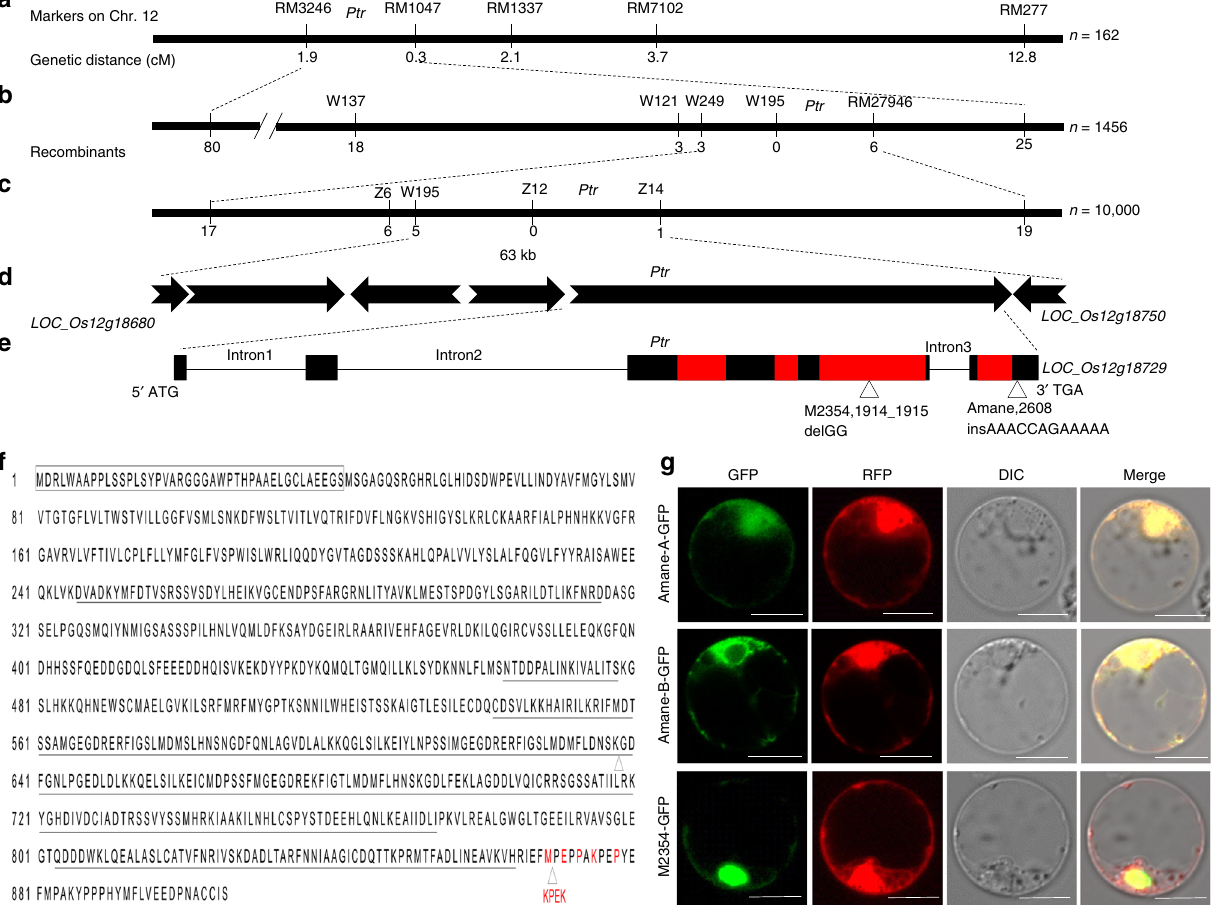
Fig. 1 Cloning and characterization of Ptr . a Ptr was mapped between SSR RM3246 and RM1047 on chromosome 12 (Chr. 12). b , c Fine mapping of Ptr to 63 kb. d Predicted open reading frames (ORFs) with indicated direction of transcription. e Diagram of Ptr , mutations identi fi ed in M2354 and Amane. Exons are indicated by black fi lled rectangles. Armadillo (ARM) repeats (Superfamily 1.75) are indicated by the red fi lled rectangles. Insertion/deletion (InDel) is indicated by triangles. f The protein sequence of Ptr in Katy. Black rectangle indicates 41 missing amino acids in A isoform (864 amino acids) compared to B isoform (905 amino acids). The ARM repeats are underlined and polymorphic regions are indicated by triangles. Compared to Katy, the 2 bp (GG) deletion of Ptr in M2354 resulted in a truncated protein with 645 amino acids, while fi ve different amino acids, as well as a four amino acid (KPEK) insertion in Amane, are indicated in red. g Subcellular localization of the Ptr-green fl uorescent protein (GFP) fusion proteins in rice protoplasts expressing cytoplasmic/nuclear-localized red fl uorescent protein (RFP). Pictures were taken 16-h after protoplast transfection. GFP, RFP, differential interference contrast (DIC), and merged channels are indicated on the top. Scale bars represent 10 μ